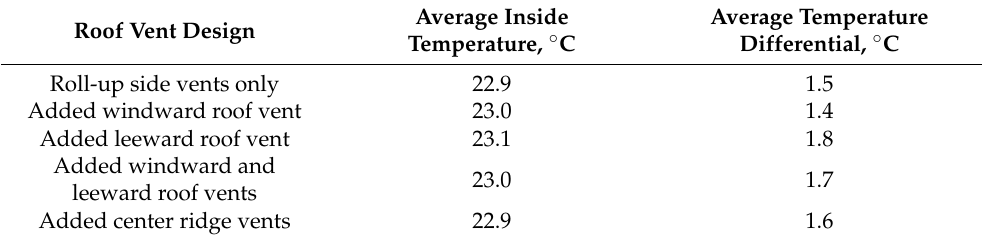
Table 5. Simulated average temperatures inside a high tunnel depending on the configuration of the roof vent. The temperature differential was calculated by subtracting the measured average outside temperature from the simulated average inside temperature. Average outside wind speed at 2.5